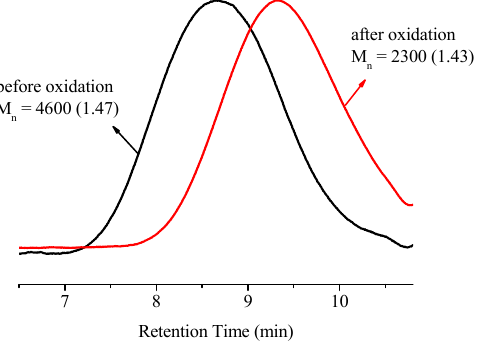
Figure 4. Gel permeation chromatograph (GPC) traces before and after oxidation using 30% H 2 O 2 .